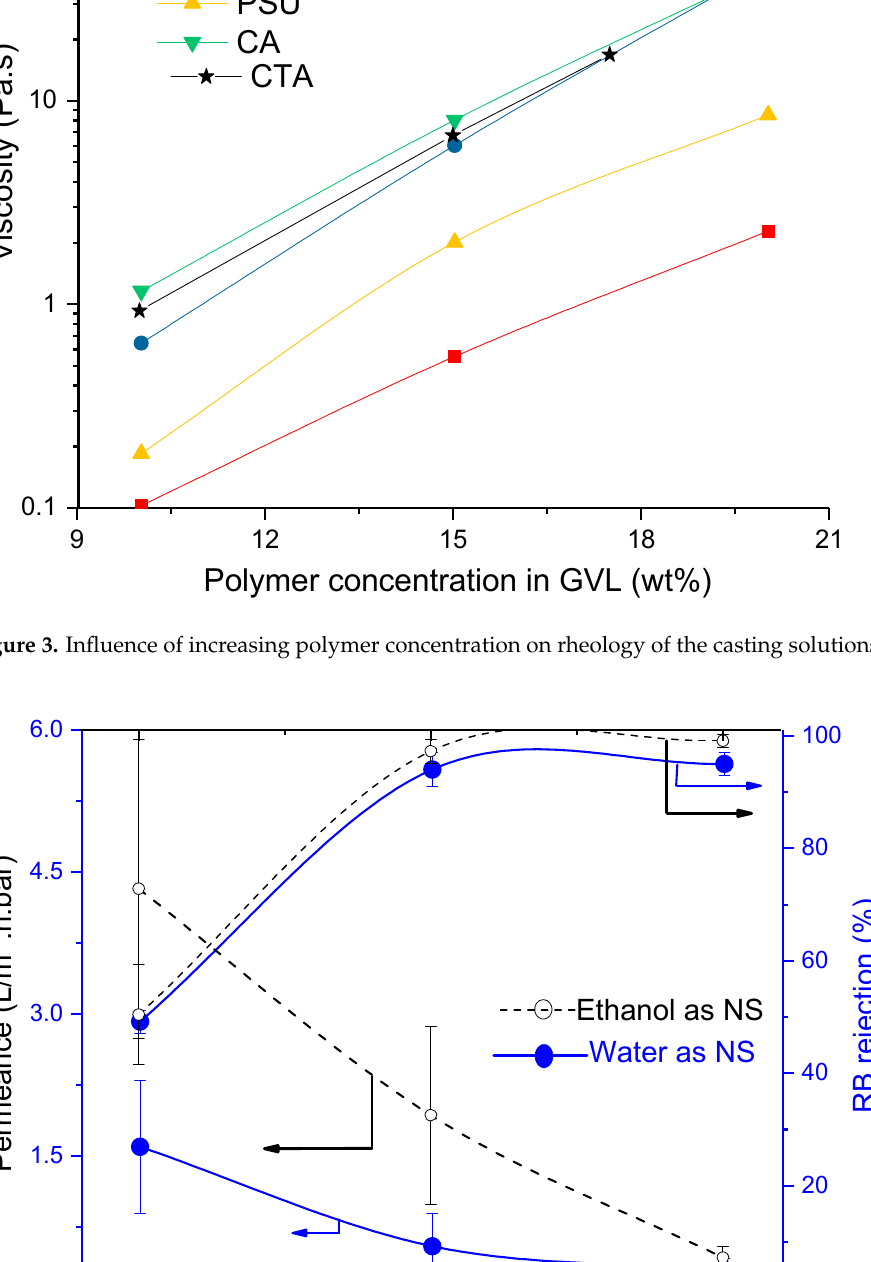
Figure 4. Influence of cellulose acetate (CA) concentration on membrane performance in terms of